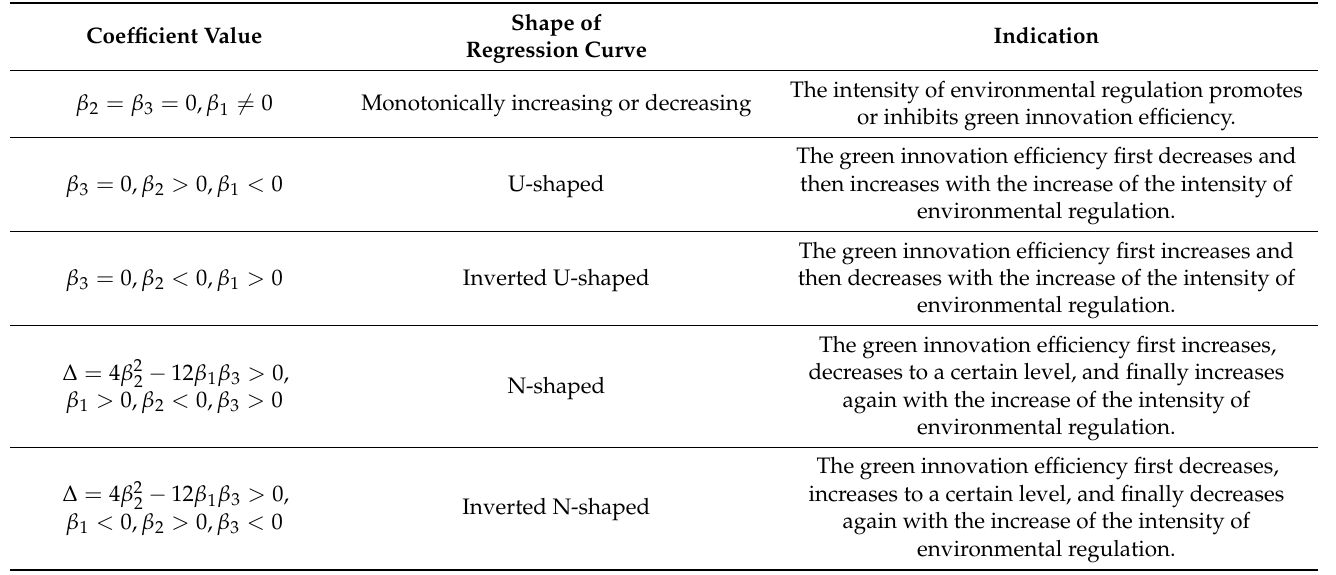
Table 1. Characteristics of some common regression curve.